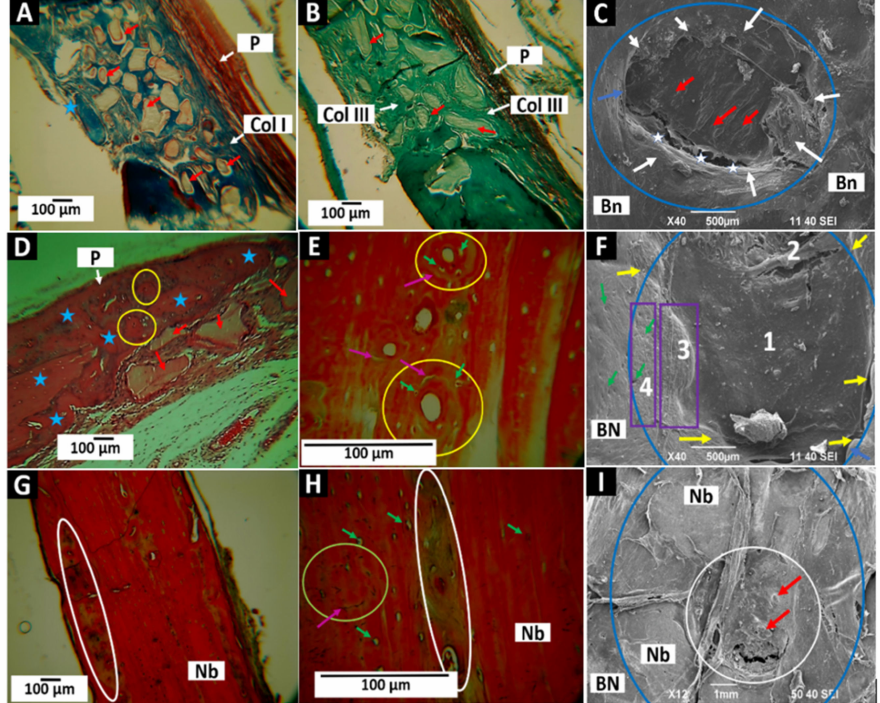
Figure 10. F2 (InterOss Collagen) material implanted in cranial bones. ( A ): Implantation at 30 days at 10 × . MT technique. ( B ): Implantation at 30 days at 10 × . GT technique. ( C ): Implantation at 30 days at 40 × . SEM technique. ( D ): Implantation at 60 days at 10 × . HE technique. ( E ): Implantation at 60 days at 10 × . GT technique. ( F ): Implantation at 60 days at 40 × . SEM technique. ( G ): Implantation at 90 days at 10 × . HE technique. ( H ): Implantation at 90 days at 40 × . HE technique. ( I ): Implantation at 90 days at 12 × . SEM technique. P: Periosteum. Col I: Type I collagen. Col III: Type III collagen. Bn: bone. Blue stars: bone tissue in formation. Blue arrows: Remaining area of the preparation. Yellow circles: “osteons-like.” Green Arrows: Osteocytic lacunae. Purple arrows: Cement lines. Red arrows: Remaining InterOss material. Nb: Newly formed bone. White oval: Areas with the remaining material. Blue circles: implantation zones. 1–3: Areas with different degrees of bone